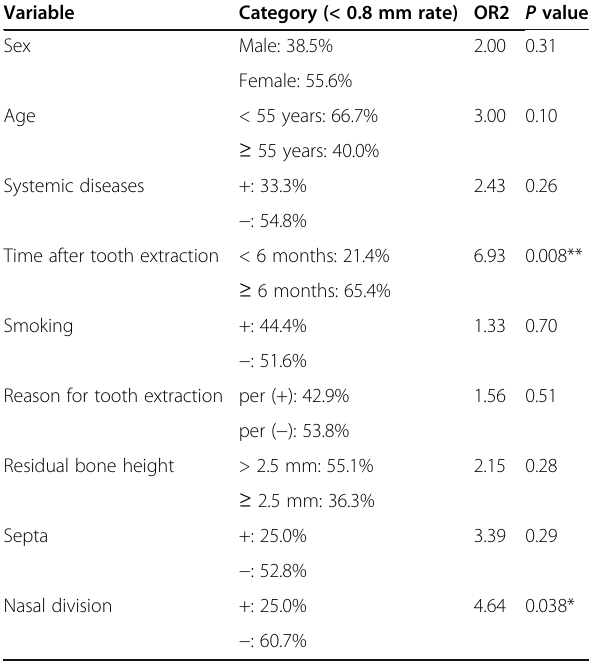
Table 4 Factors influencing sinus mucosal thickness (< 0.8